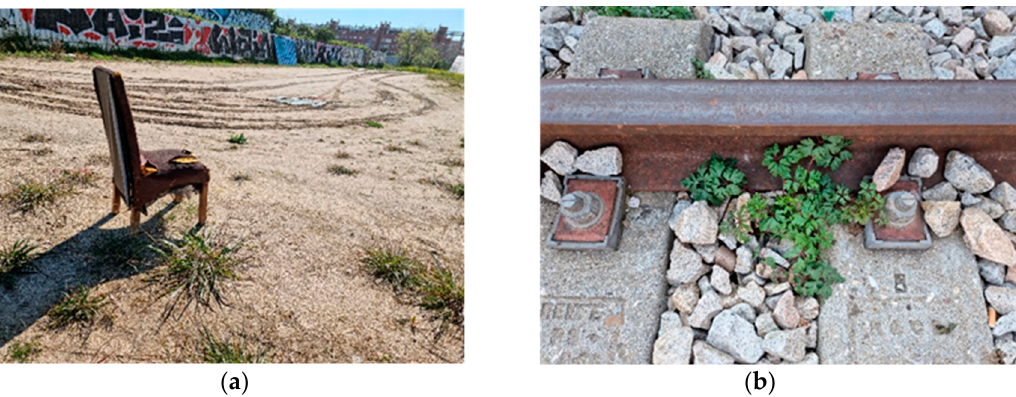
Figure 1. State of abandonment of the public space of the PVF: ( a ) surroundings of the Delicias station; ( b ) wild flora on the roads. Photos by Ram ó n G ó mez of Herba Nova for the TRAHERE project.